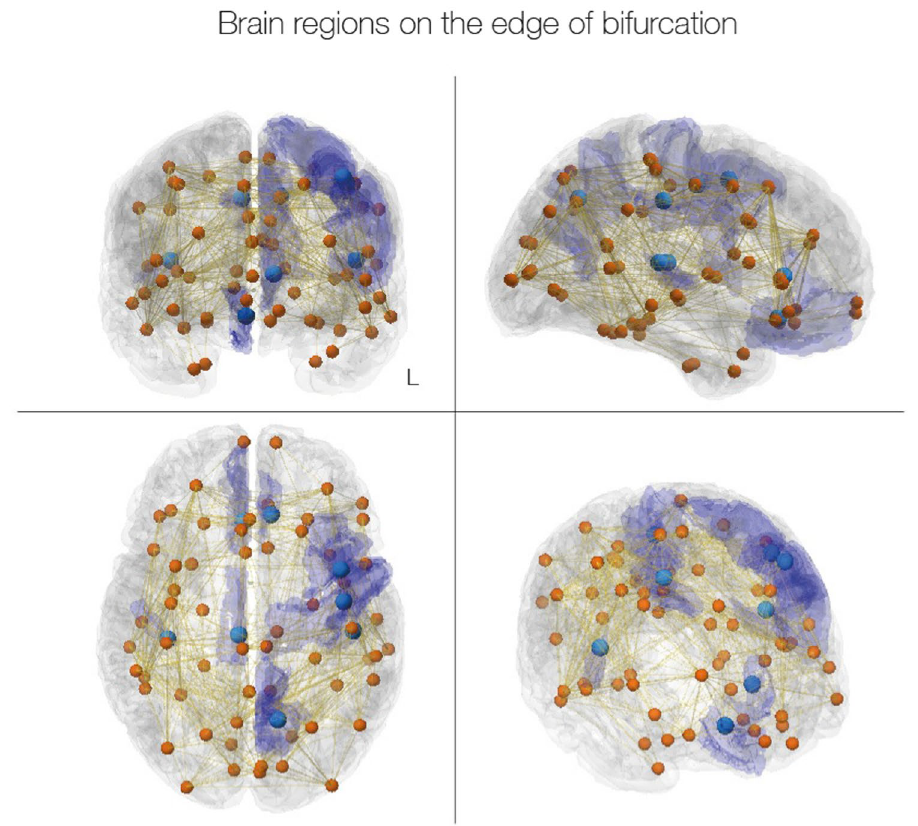
Figure 6. Dynamical core in the human brain. The figure shows the dynamical core regions on the edge of bifurcation (location of neural masses shown in light blue and transparent blue for the full region). These are the nodes with the ability to react immediately to changes in the predicted input and thus likely to drive the rest of the brain networks. The eight regions are clearly lateralised; and in the right hemisphere encompass medial orbitofrontal cortex, posterior cingulate cortex and transverse temporal gyrus, while in the left hemisphere include caudal middle frontal gyrus, precentral gyrus, precuneus cortex, rostral anterior cingulate cortex and transverse temporal gyrus. Interestingly, some of these regions are part of the default mode network (medial orbitofrontal cortex, posterior cingulate cortex and precuneus cortex) while others have been implicated in memory processing (parahippocampal and transverse temporal gyrus), auditory processing (transverse temporal gyrus), selection for action (rostral anterior cingulate cortex and caudal middle frontal gyrus) and motor execution (precentral